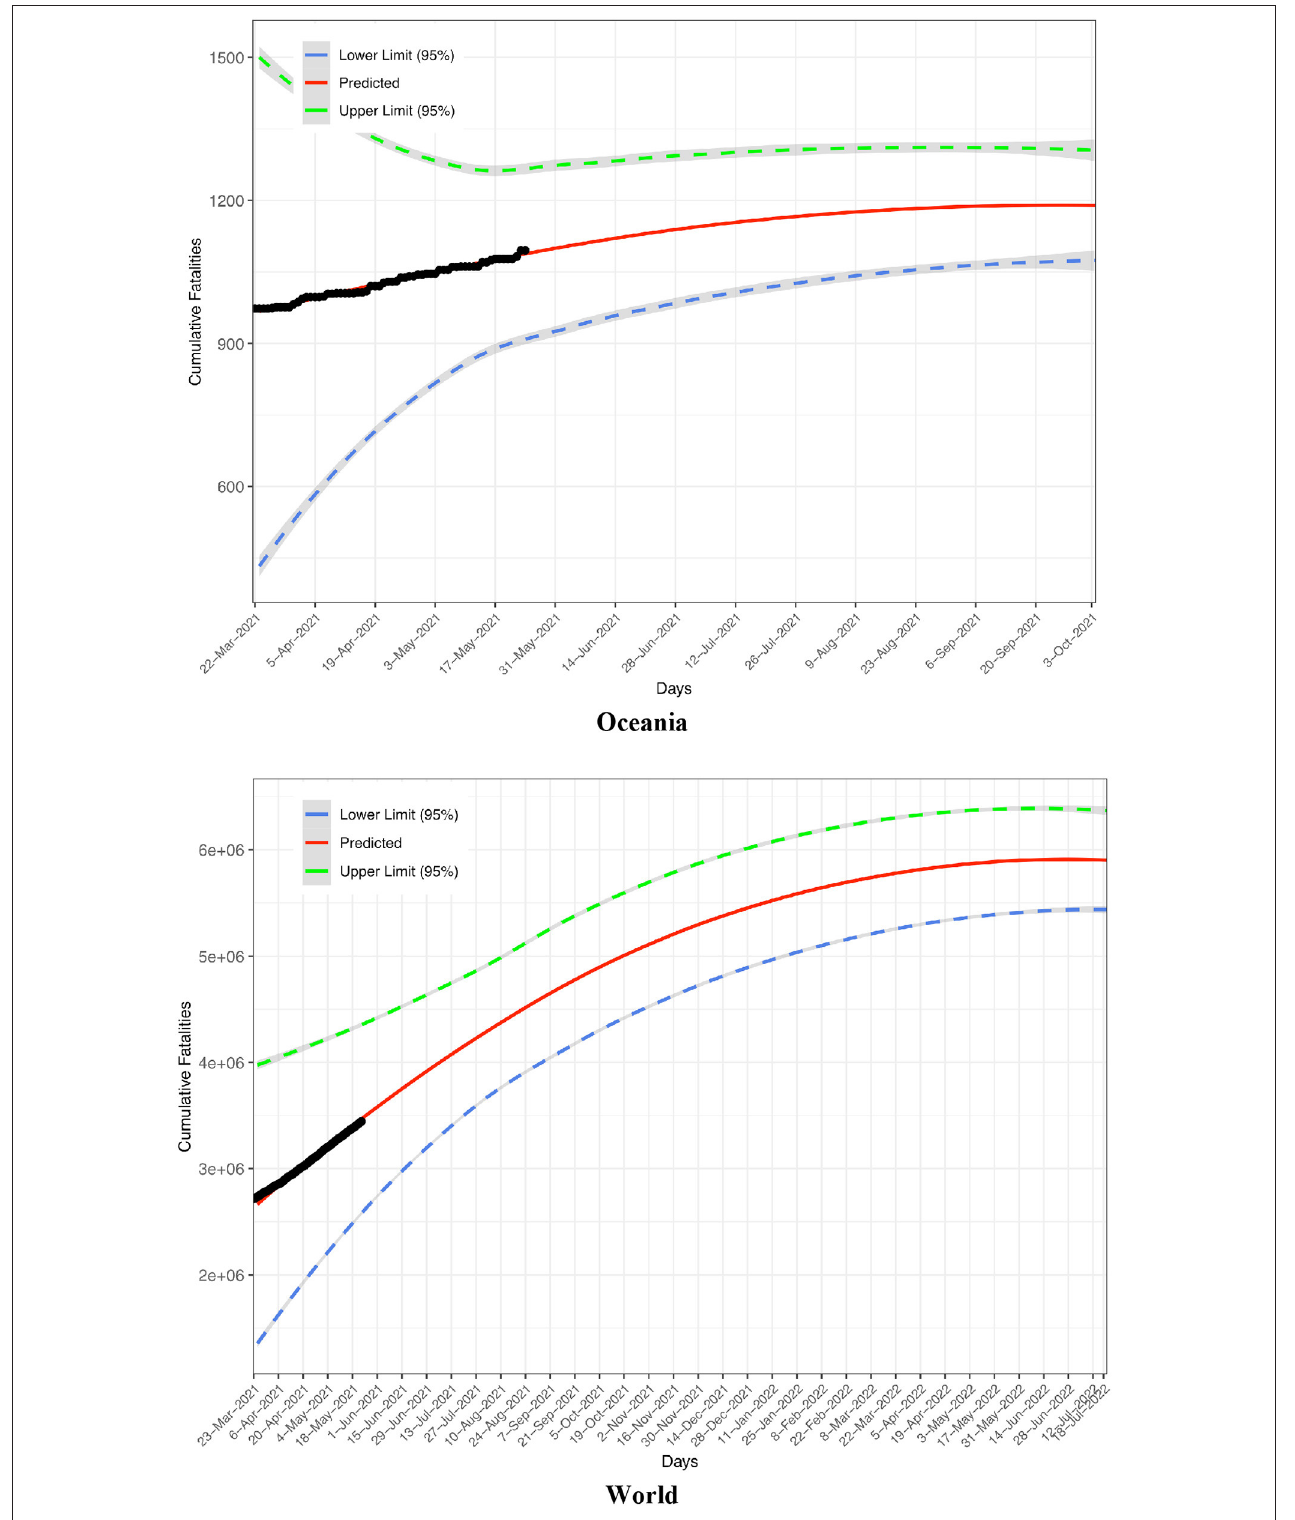
FIGURE 3 | Predicted fatality number (solid curve in red), lower and upper bounds (dashed lines), and observed fatality number (solid cycles in black) for five continents and the world: Africa, Europe, North America, South America, Oceania, and the World.